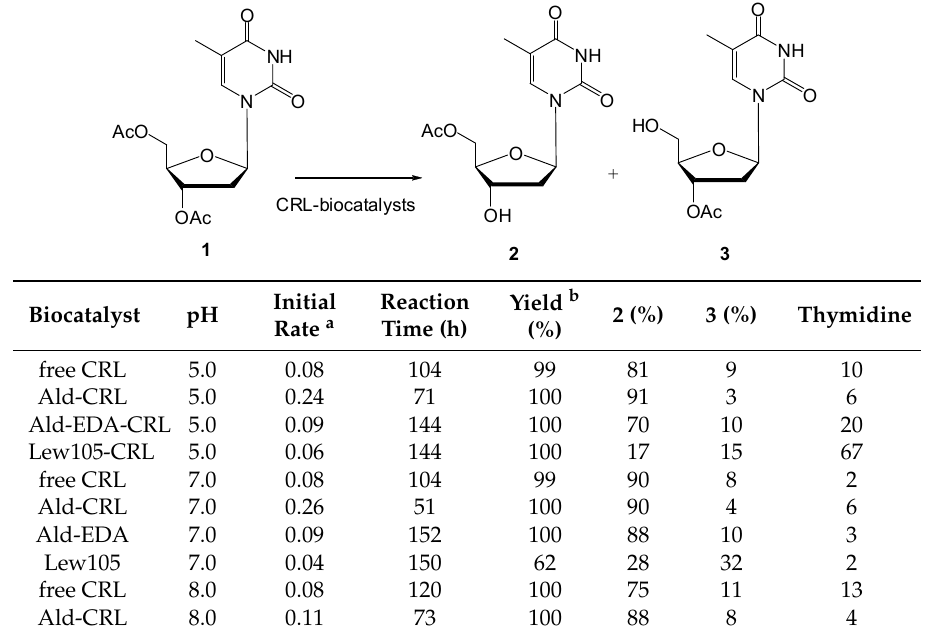
Regioselective deprotection of 3,5- O -diacetylated thymidine 1 with different aldehyde-activated CRL biocatalysts at 25 ˝ C in aqueous